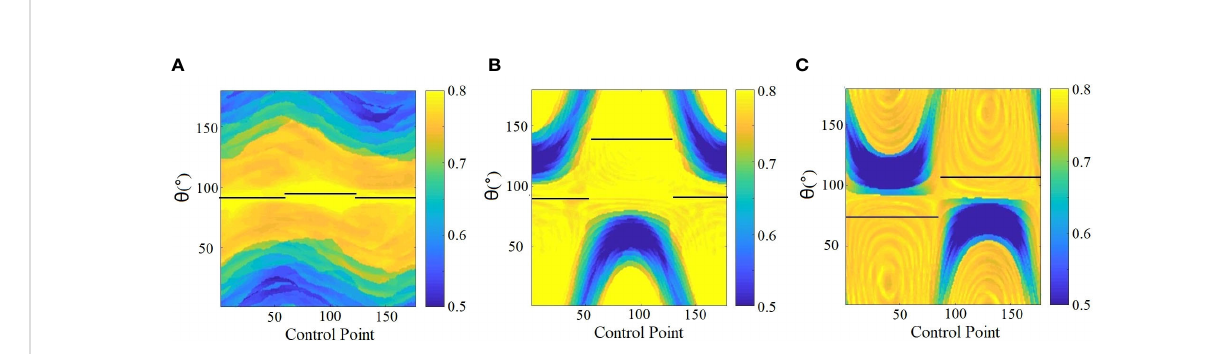
FIGURE 3 Determination of sub-arc segmentation and related collimator angles (depicted with black solid lines) based on the SACAO method for three patients (A – C) . The color scale represent MCI values, and the black solid line indicated optimal collimator angle for each